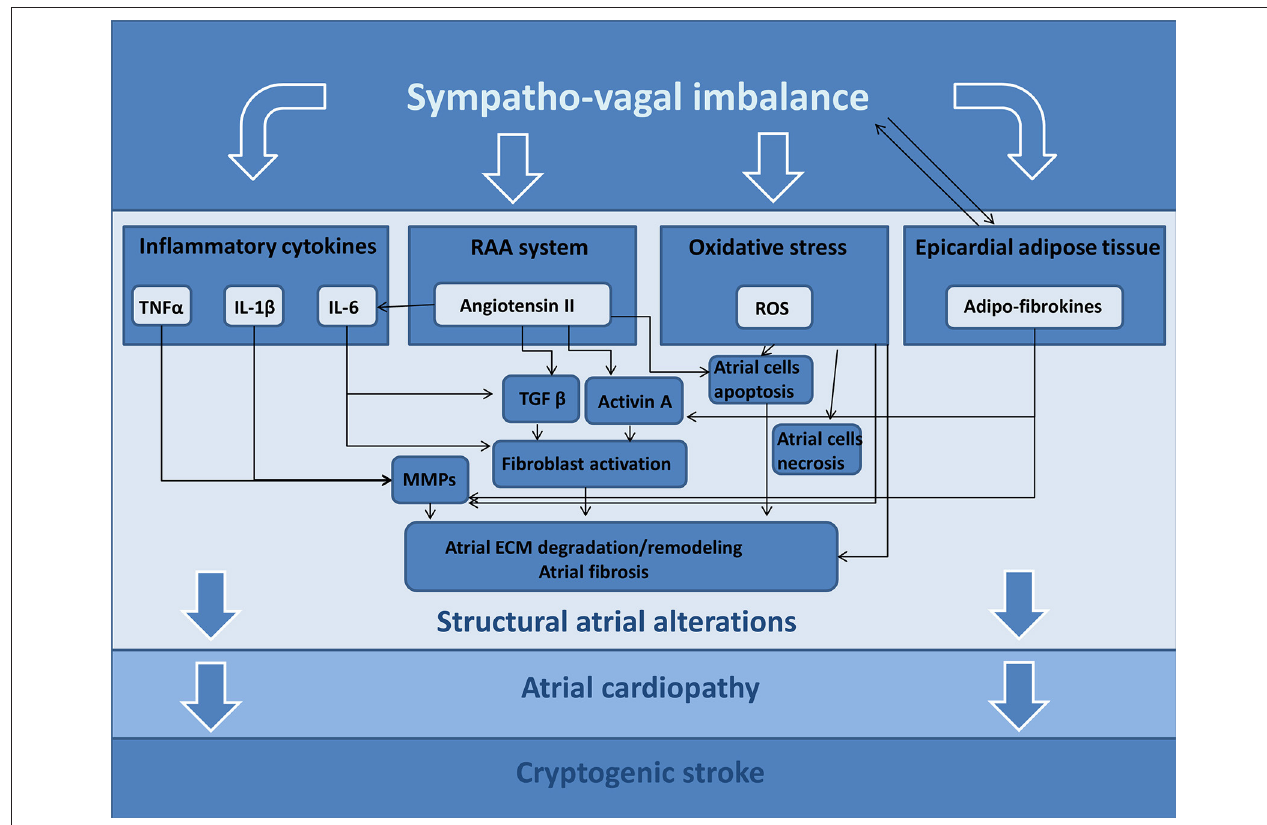
FIGURE 2 | Possible ANS-related mechanisms promoting atrial cardiopathy and cryptogenic stroke. TNF α , tumor necrosis factor alpha; IL-1 β , Interleukin 1 Beta; IL-6, Interleukin 6; RAA, renin-angiotensin-aldosterone; ROS, reactive oxygen species; MMPs, matrix metalloproteinases; ECM, extracellular